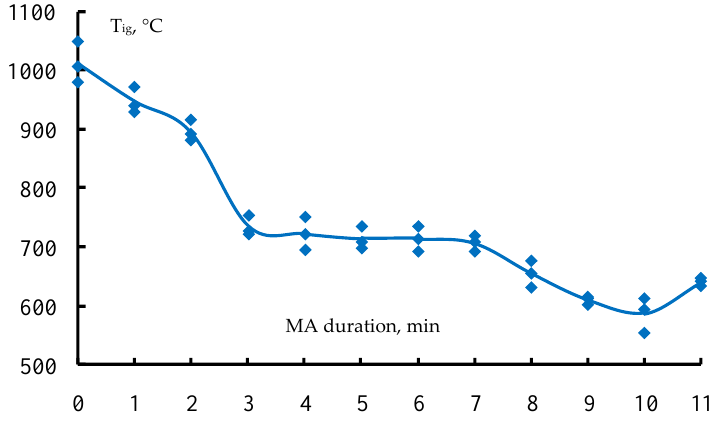
Figure 4. Dependence of the self-ignition temperature on the duration of the MA of the Ti–C–Co–Ca 3 (PO 4 ) 2 –Ag–Mg powder mixtures at X = 13%.